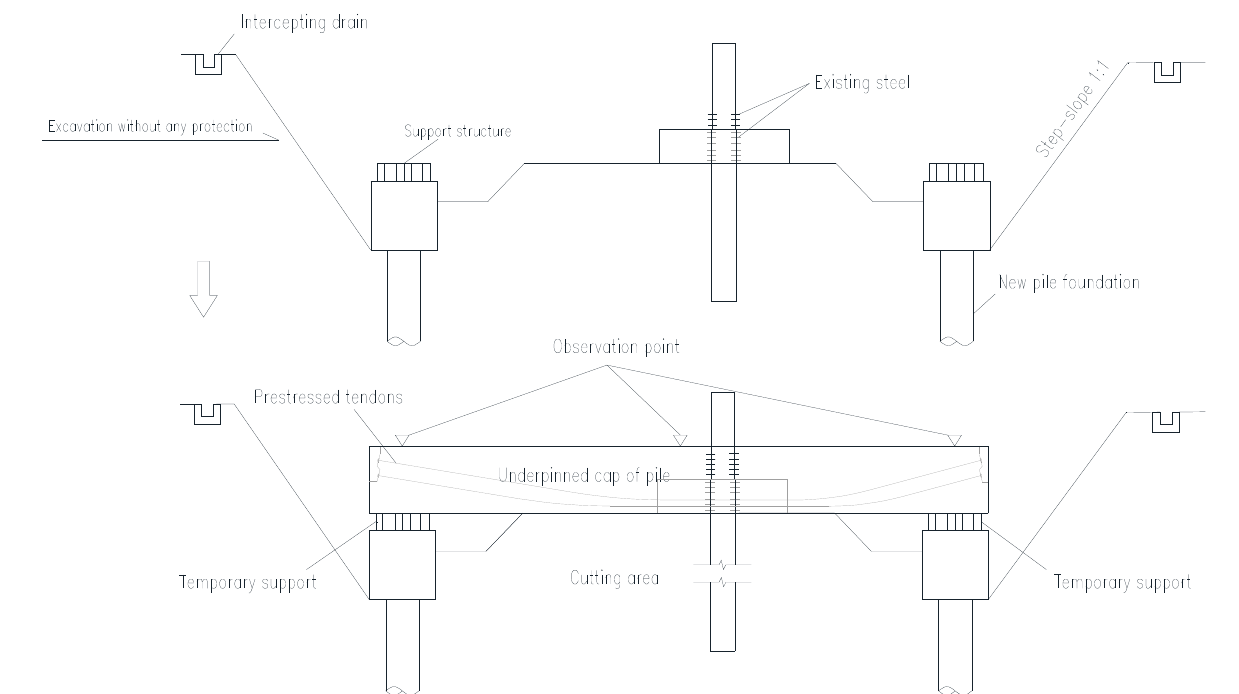
Figure 3. Construction process of the pile foundation underpinning.